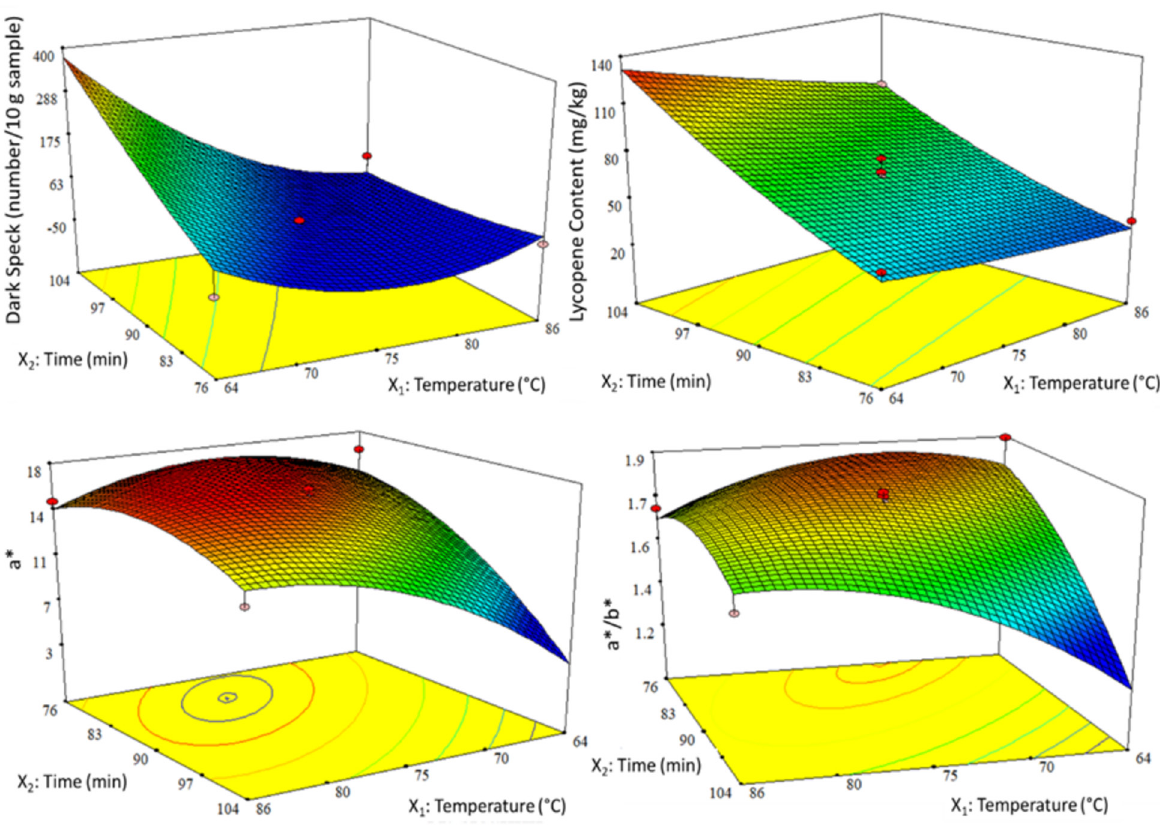
Figure 2. Calculated effects of process variables; cooking temperature and cooking time on dark speck, lycopene content, a* and a*/b* of vacuum evaporated tomato